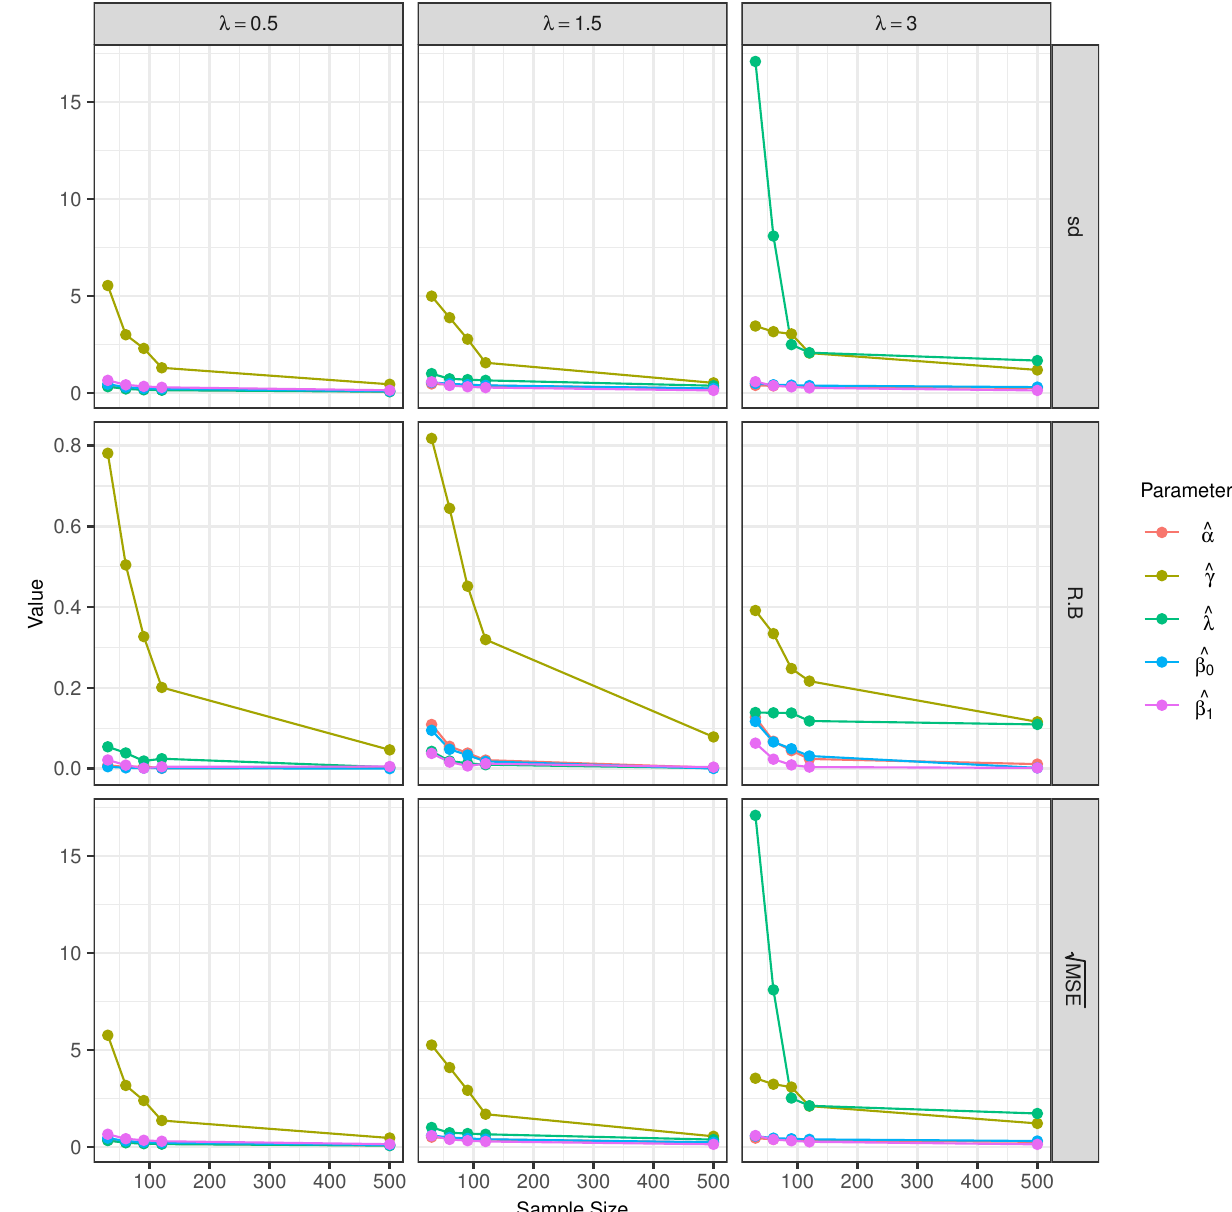
√ MSE for the estimators of the EGSHN ( 1.75,2.25,0.75,2.0, λ ) model parameters with